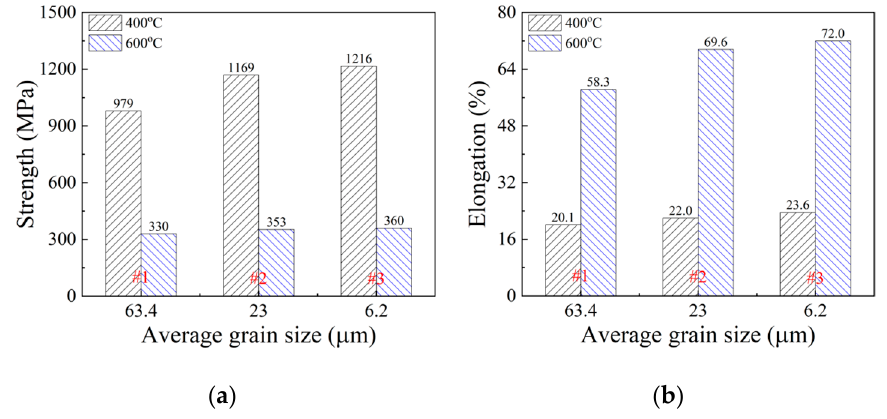
Figure 15. Relationships of tensile strength ( a ) and elongation ( b ) with average grain size.